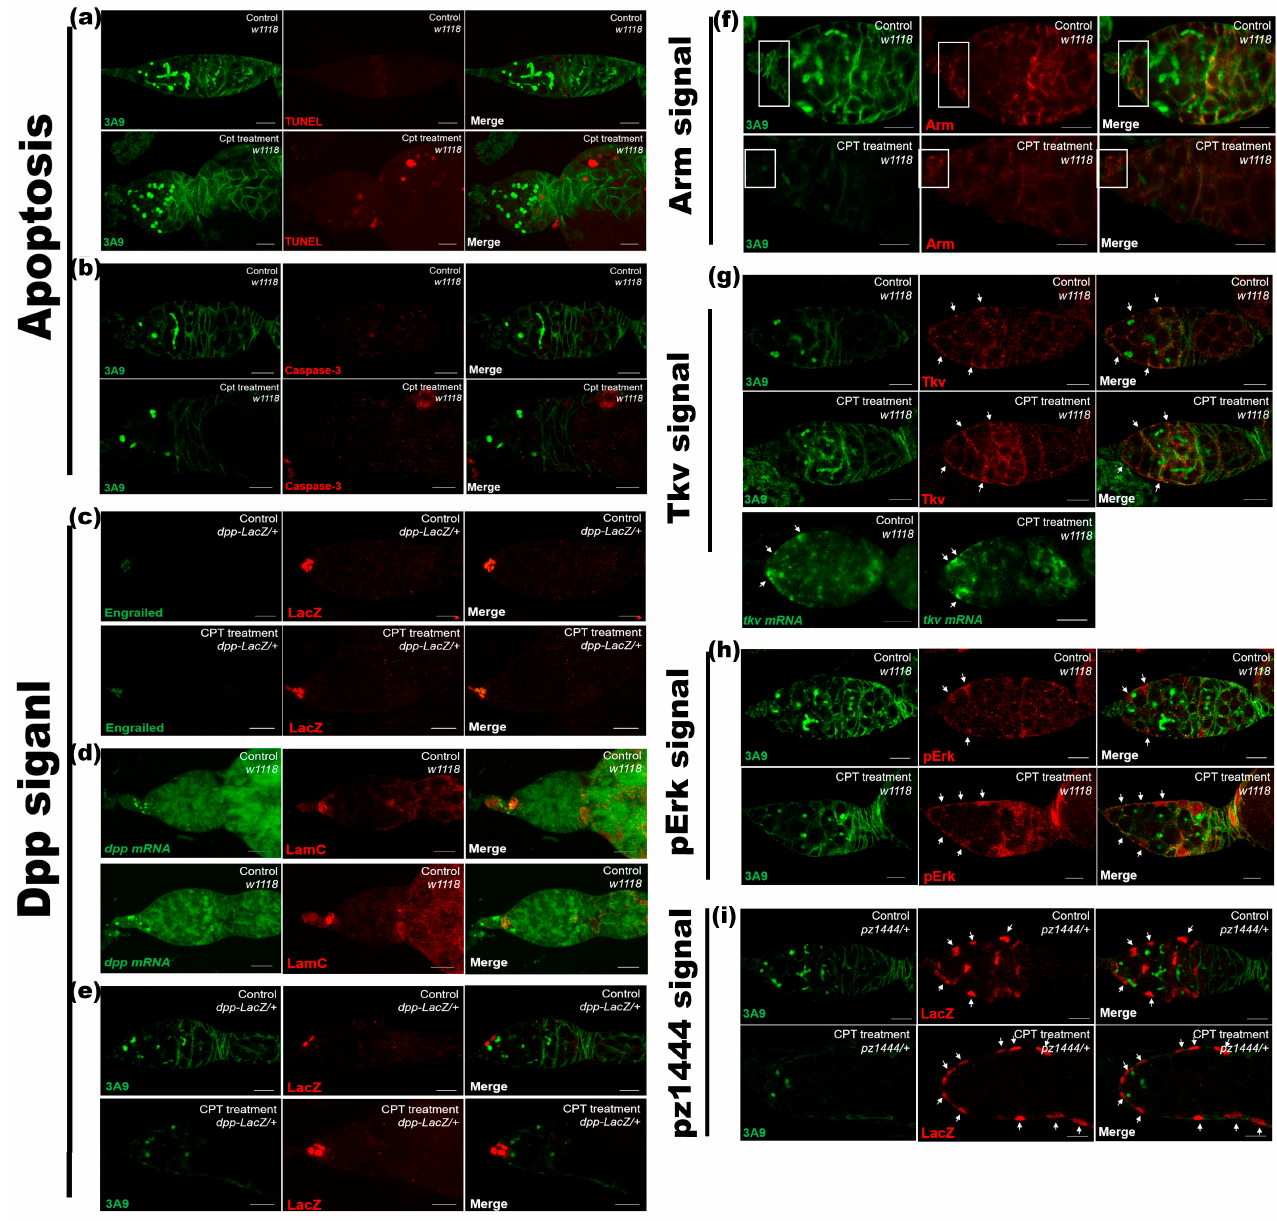
Figure 2. The roles of apoptosis and niche in CPT-induced GSCs loss. ( a ) Apoptotic signals from ovaries of control and CPT treated flies labeled with TUNEL (red) and stained with anti-3A9 (green). ( b ) Caspase-3 activity in CPT-treated and control germarium staining by Hoechst (white), Caspase-3 (red), and anti-3A9 (green). ( c ) Control and CPT-treated germaria with anti-En (green) and anti-LacZ (red) staining. ( d ) In situ hybridization examining dpp expression with anti-LamC (red) staining. ( e ) Control and CPT-treated germaria with anti-LacZ (red) and anti-3A9 (green) staining. ( f ) Arm immunoprecipitation with or without CPT exposure with Arm (red) and anti-3A9 (green) staining. Meanwhile, square flame indicated the expression of Arm. ( g ) Control and CPT-treated germaria with anti-Tkv (red) and anti-3A9 (green) staining, and in situ hybridization showing tkv mRNA expression in control and CPT-treated germaria. ( h ) Control and CPT-treated EC with anti-pErk (red) and anti-3A9 (green) staining. White arrow indicated the signal of pErk. ( i ) Control and CPT-treated EC with anti-LacZ (red) and anti-3A9 (green) staining. White dashed circle indicated ectopic location of ECs. Newly emerged flies (1 day post emergence) were treated with 100 mg/L CPT and control flies received equal amount of DMSO. The flies were dissected at the 9th day post treatment. Scale bar, 10 µ